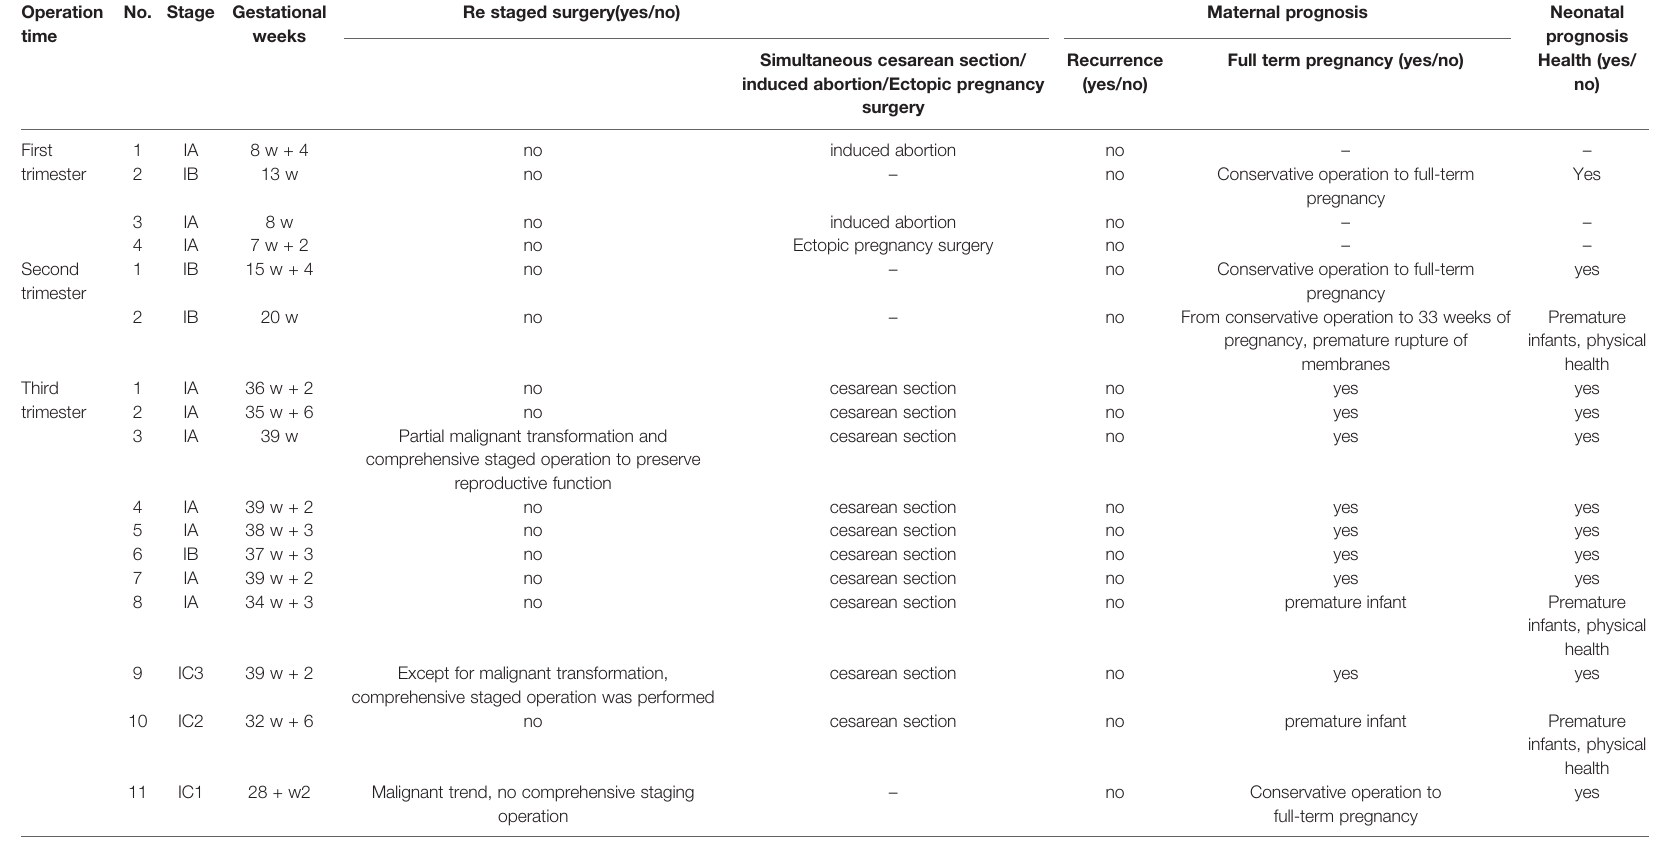
TABLE 4 | Maternal and infant prognosis. Operation